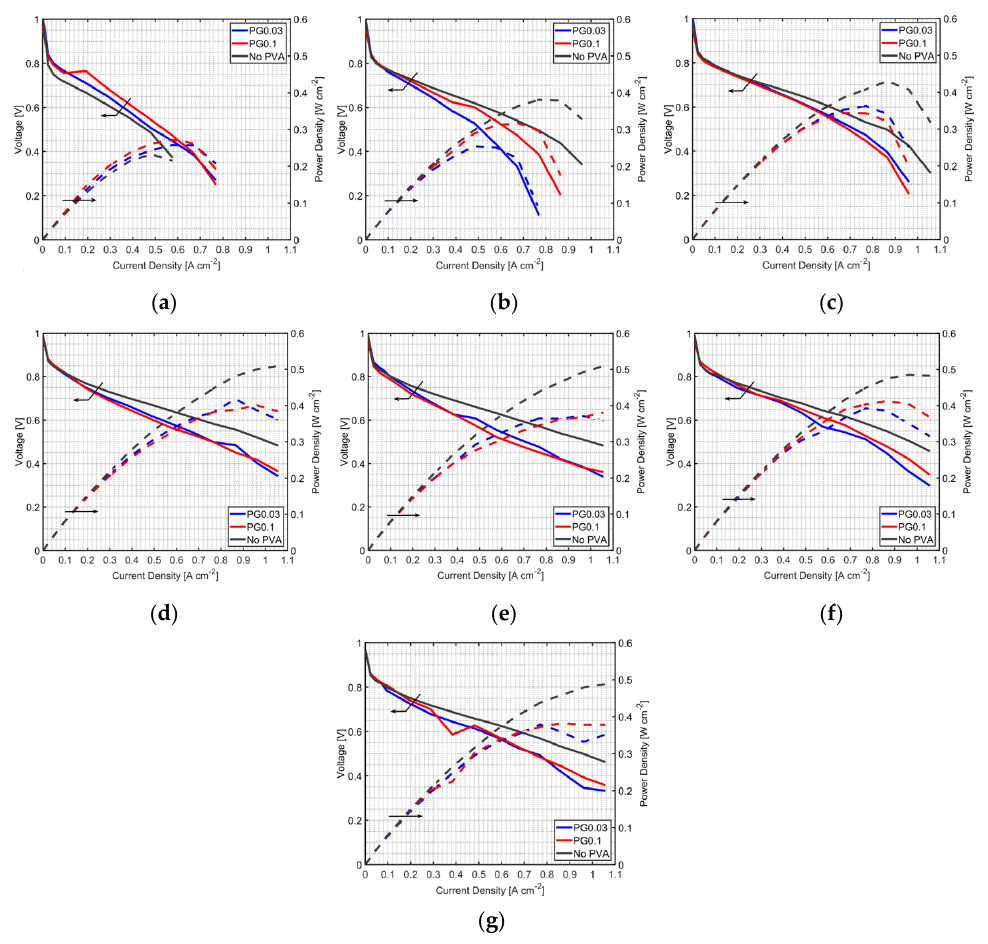
Figure 5. MEA with the PG method at a fuel cell temperature of 60 °C, with a non-humidified anode and a cathode humidifier temperature of ( a ) 25 °C, ( b ) 30 °C, ( c ) 40 °C, ( d ) 50 °C and ( e ) 60 °C; and a fuel cell temperature of 70 °C, a non-humidified anode and a cathode humidifier temperature of ( f ) 60 °C and ( g ) 70 °C.